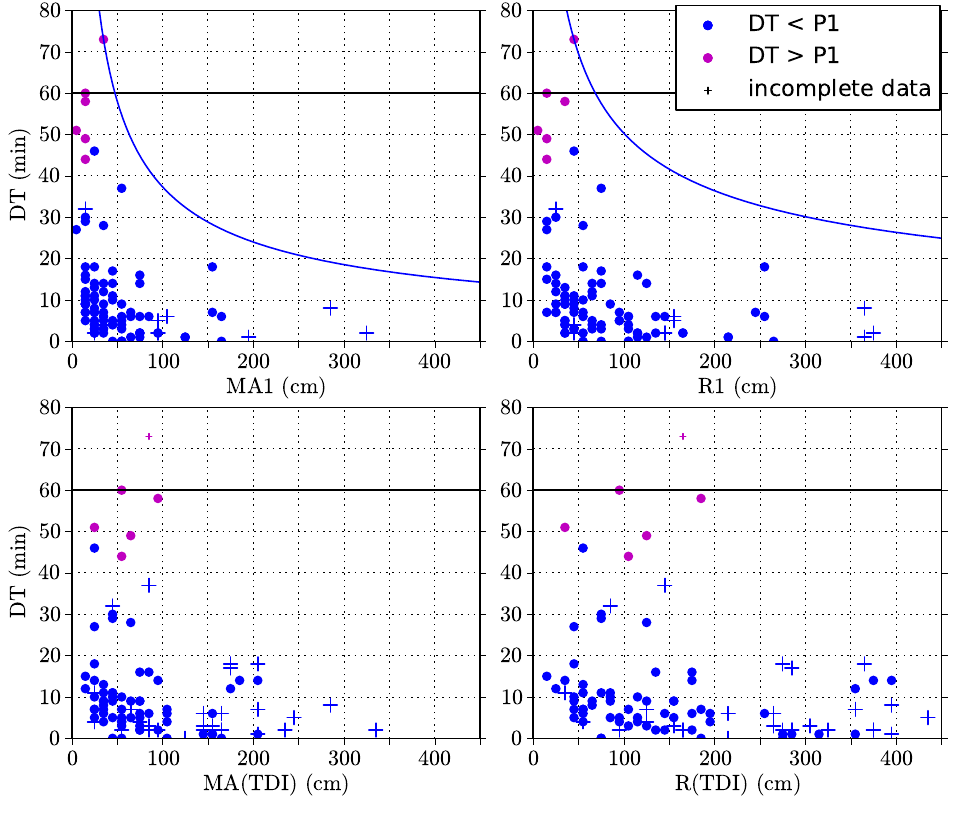
Fig. 9. Delay time DT for the tsunami detection method vs. the first wave maximum amplitude MA1 (top left) and range R1 (top right), the maximum peak amplitude (bottom left) and the range (bottom right) in TDI. Circles refer to complete records, while crosses mark records with data gaps or with saturated samples. Detections occurring on the first wave are blue, those occurring later are pink. The total number of detections is 95. For the plot of DT vs. MA1, a possible envelope is determined by the parameter values a=7 . 05 × 10 2 and b=0.64, while for the plot of DT vs. R1, the envelope parameters are a=4 . 31 × 10 2 and